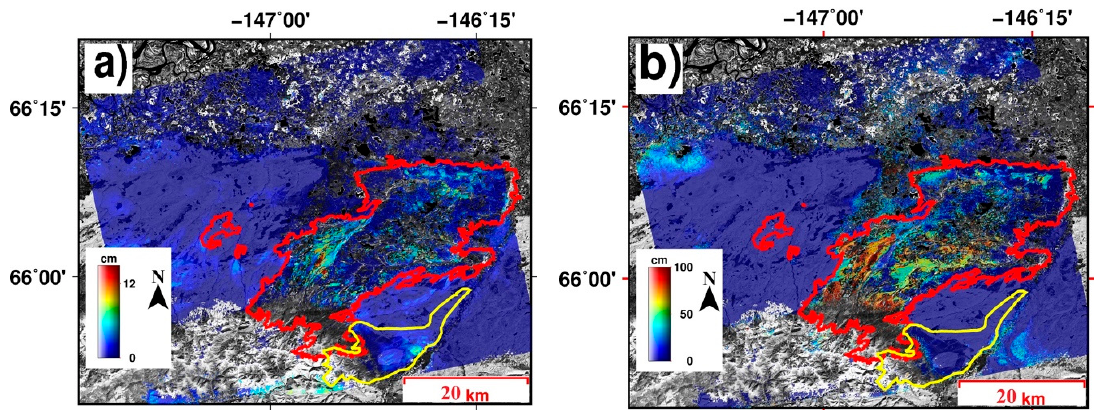
Figure 6. Total thickness of ( a ) thawed excess ice and ( b ) pore ice permafrost during the second post-fire thaw season.